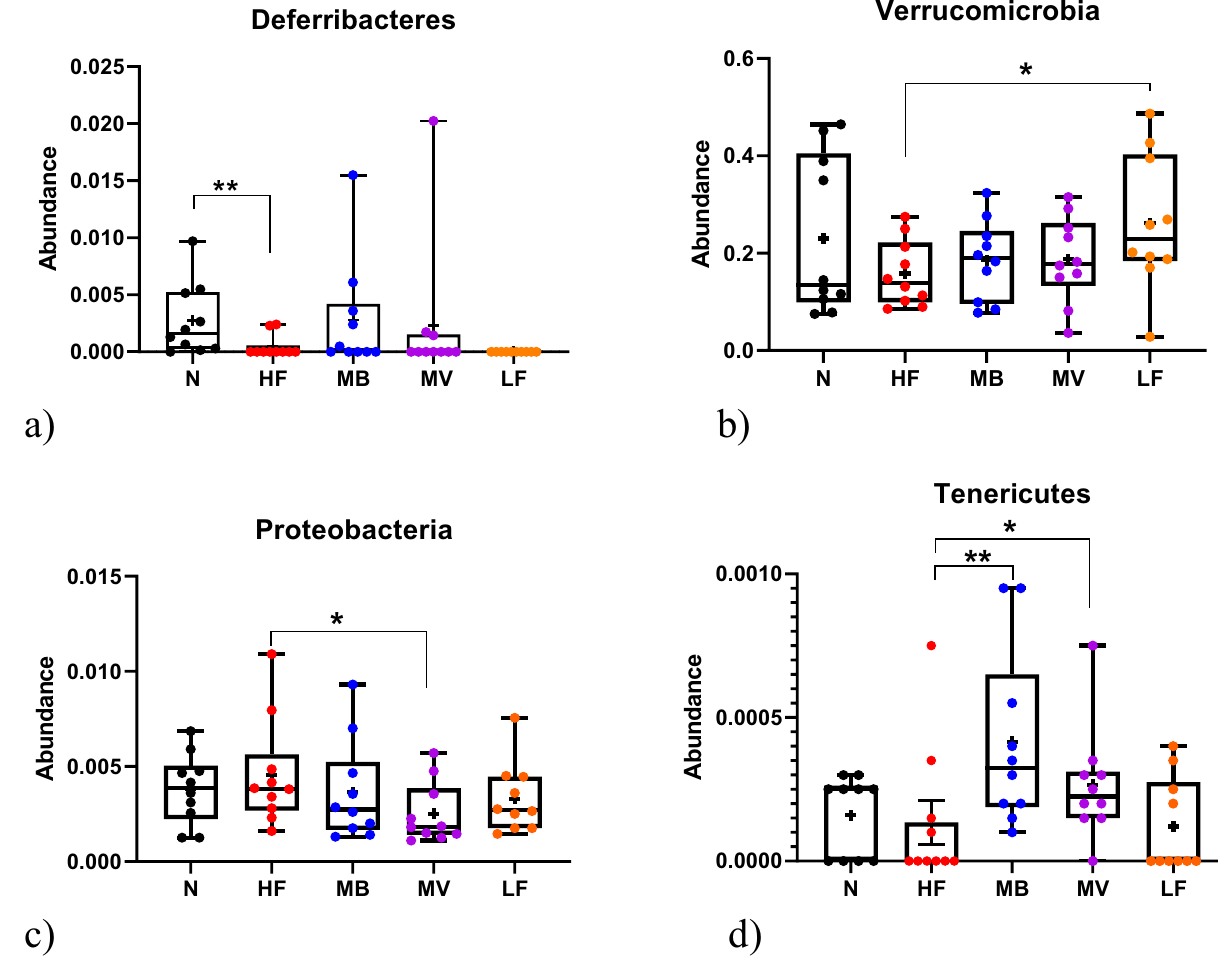
Figure 1. Caecal microbiota at phylum level. ( a ) Deferribacteres , ( b ) Verrucomicrobia , ( c ) Proteobacteria and ( d ) Tenericutes in conventional rats (N) fed a high-fat diet and ApoE-/- rats fed either a low-fat diet (LF), a high-fat diet as it is (HF) or supplemented with 1% monobutyrin (MB) or monovalerin (MV). Box and whisker plots show minimum to maximum values, central lines presenting medians and means shown as “ + ”. All data are compared with the HF group. Significant differences compared with this group: *, p < 0.05; **, p <